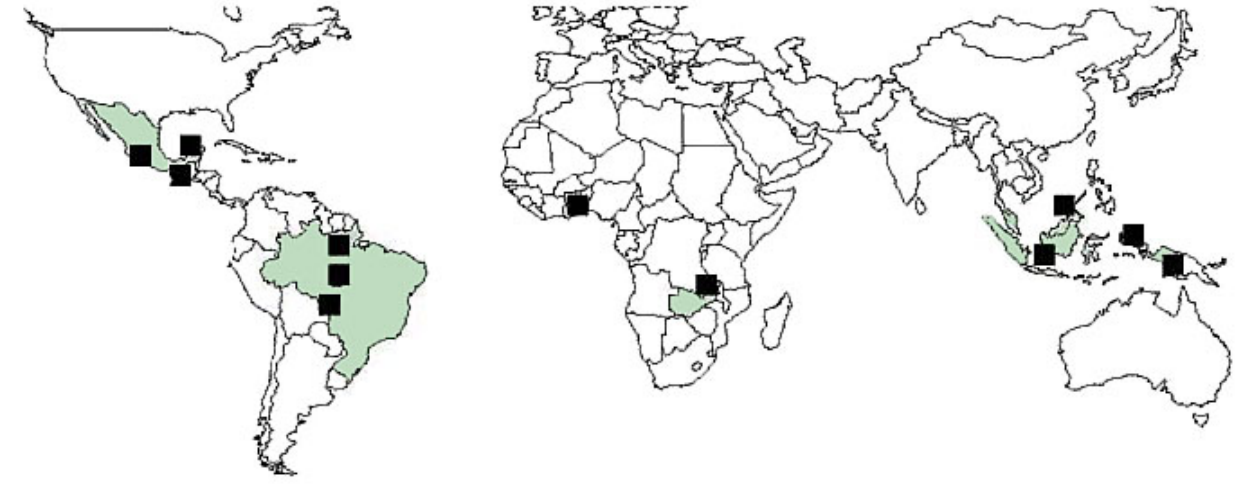
Fig. 1. Overview map indicating the location of the 12 cases evaluated in six